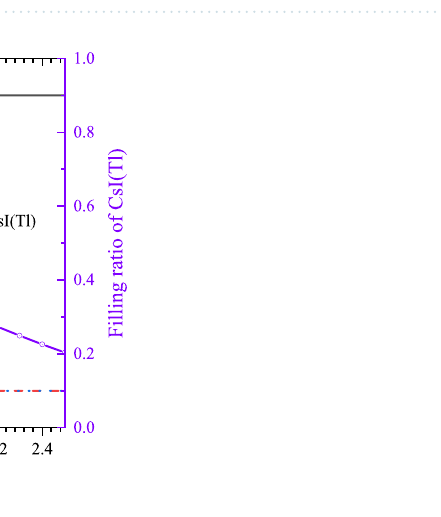
Figure 2. Variation of h 1 , h 2 , and h 3 with t Si , and variation of the filling ratio of CsI(Tl) with t Si